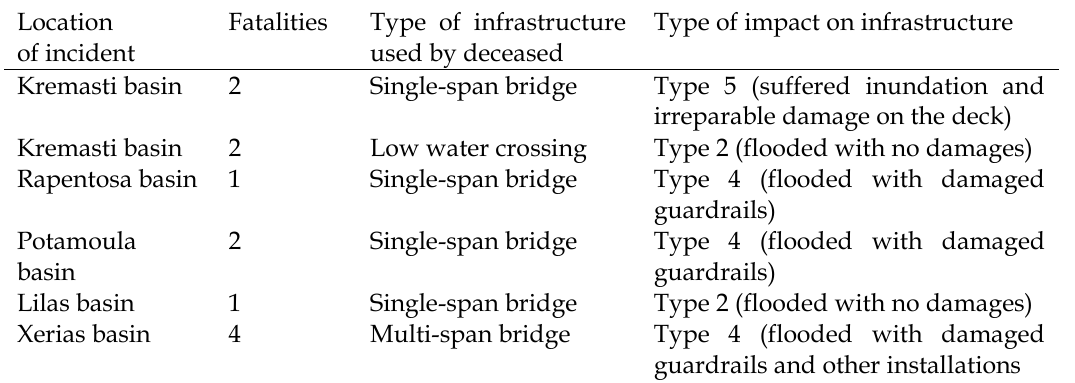
Table 4. Details of fatal incidents caused by the extreme precipitation